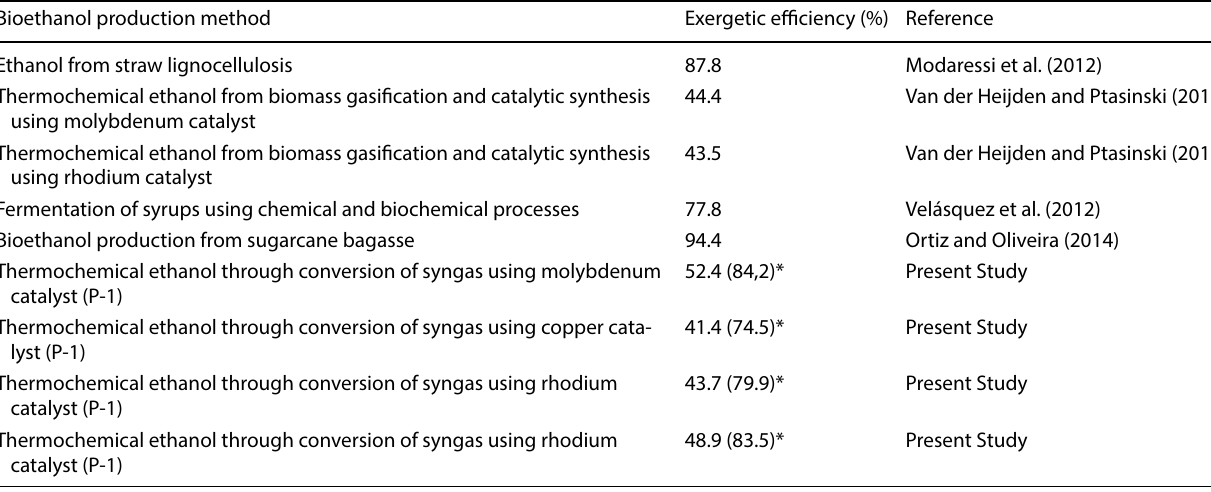
Table 5 Comparison of the exergetic efficiency values for the different production routes considering only bioethanol as a product